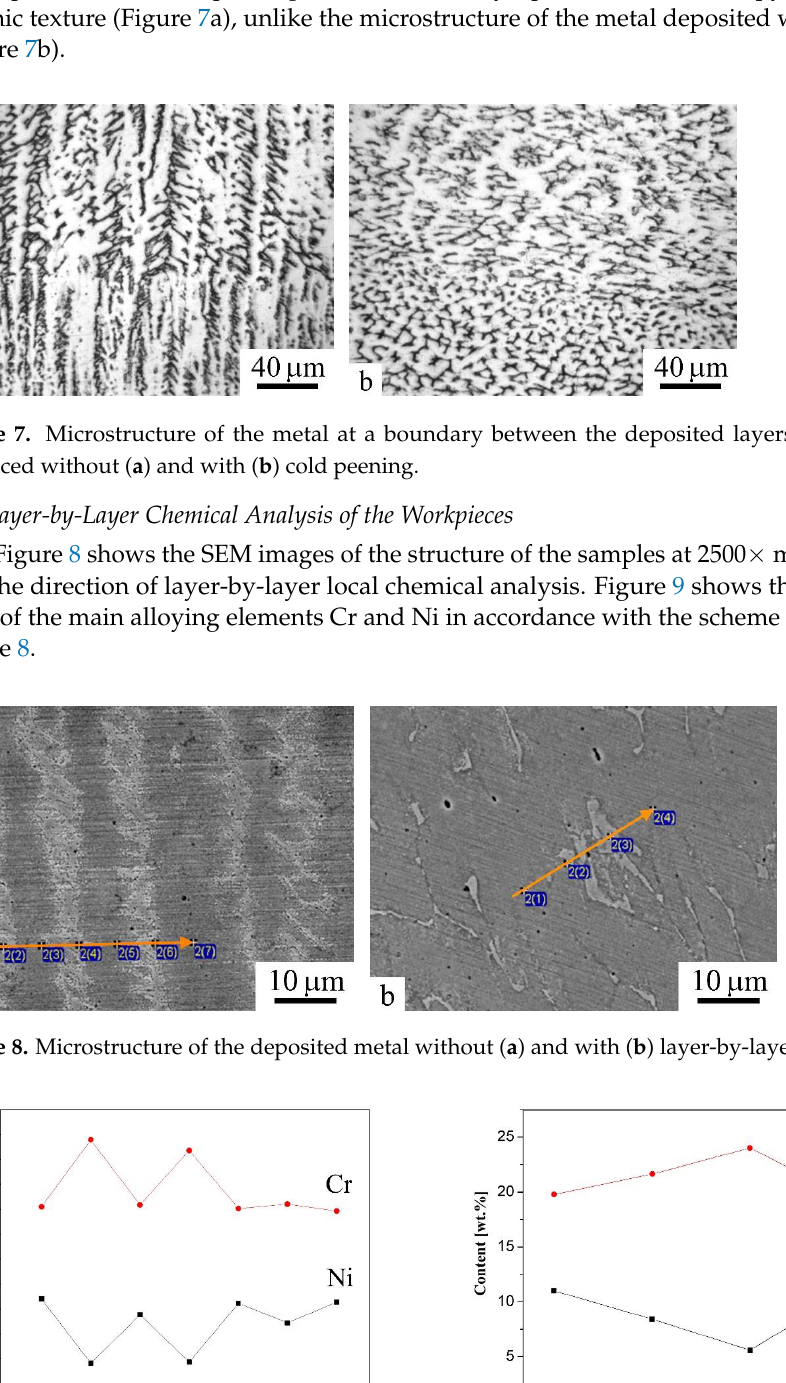
Figure 6. General view of the microstructure of the metal deposited without ( a ) and with ( b ) layer- by-layer peening.